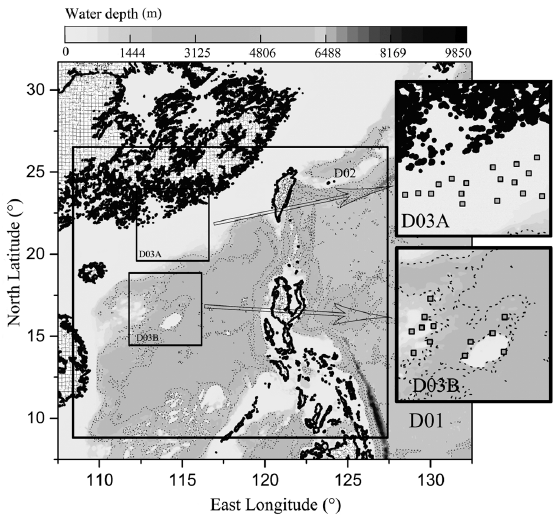
Figure 1. The simulating waves nearshore (SWAN) domain configuration shown on top of the hydrology map of the South China Sea. Twenty nine potential floating wind farm sites are indicated by small squares.